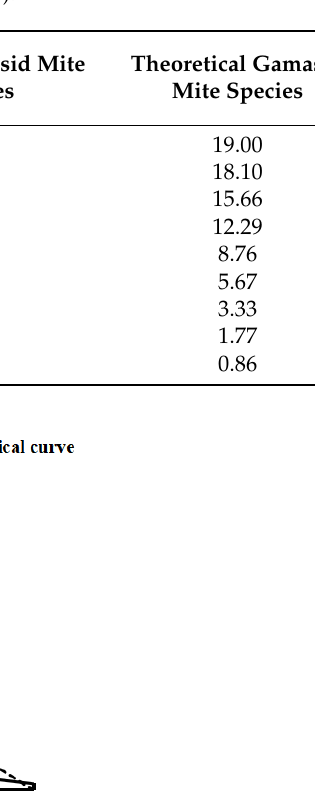
Table 6. The fitting results of species abundance distribution of gamasid mite community in Three Parallel Rivers Area in northwest Yunnan of China (2001 – 2015).